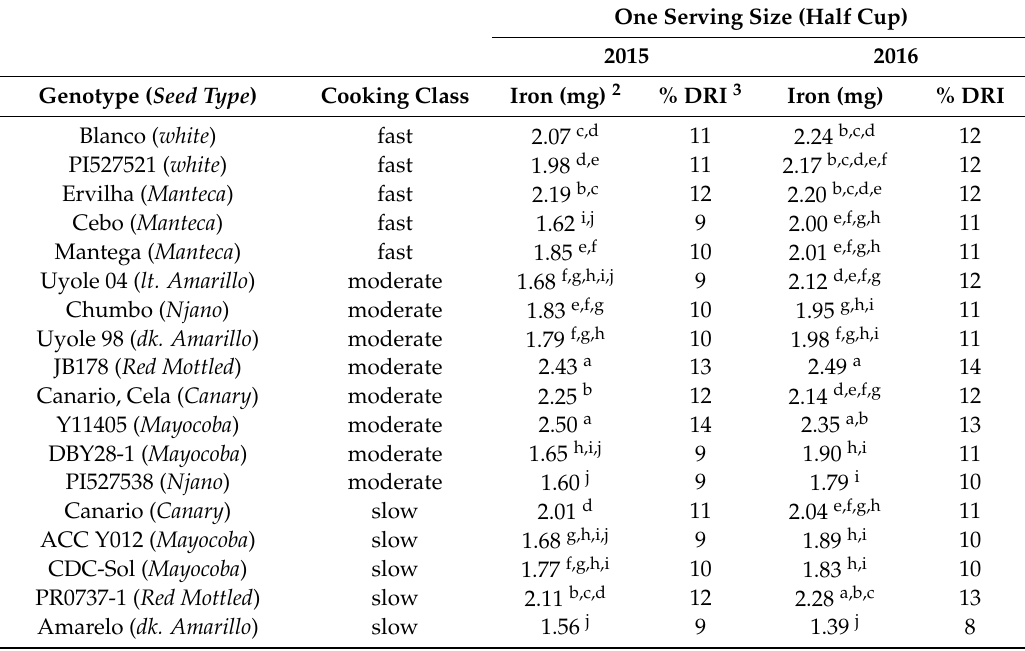
Table 5. Cooked Seed Iron Density of Unsoaked Genotypes in the Yellow Bean Panel Organized by Cooking Class 1